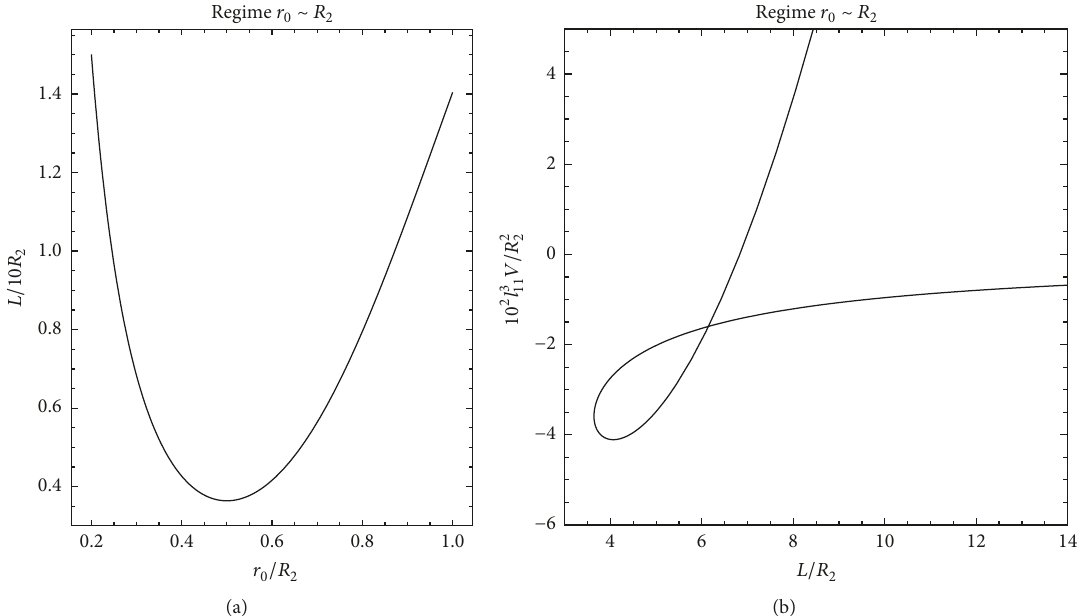
Figure 8: (a) Distance 𝐿/𝑅 2 between quarks in a M2 brane space versus 𝑟 0 /𝑅 2 . Here 𝑟 1 /𝑅 2 = 10 4 , 𝑟 0 /𝑅 ≤ 1 , and 𝑟 ∗ /𝑅 = 0.500 . (b) Potential 𝑙 3 𝑉/𝑅 2 11 2 between quarks in a M2 brane space versus